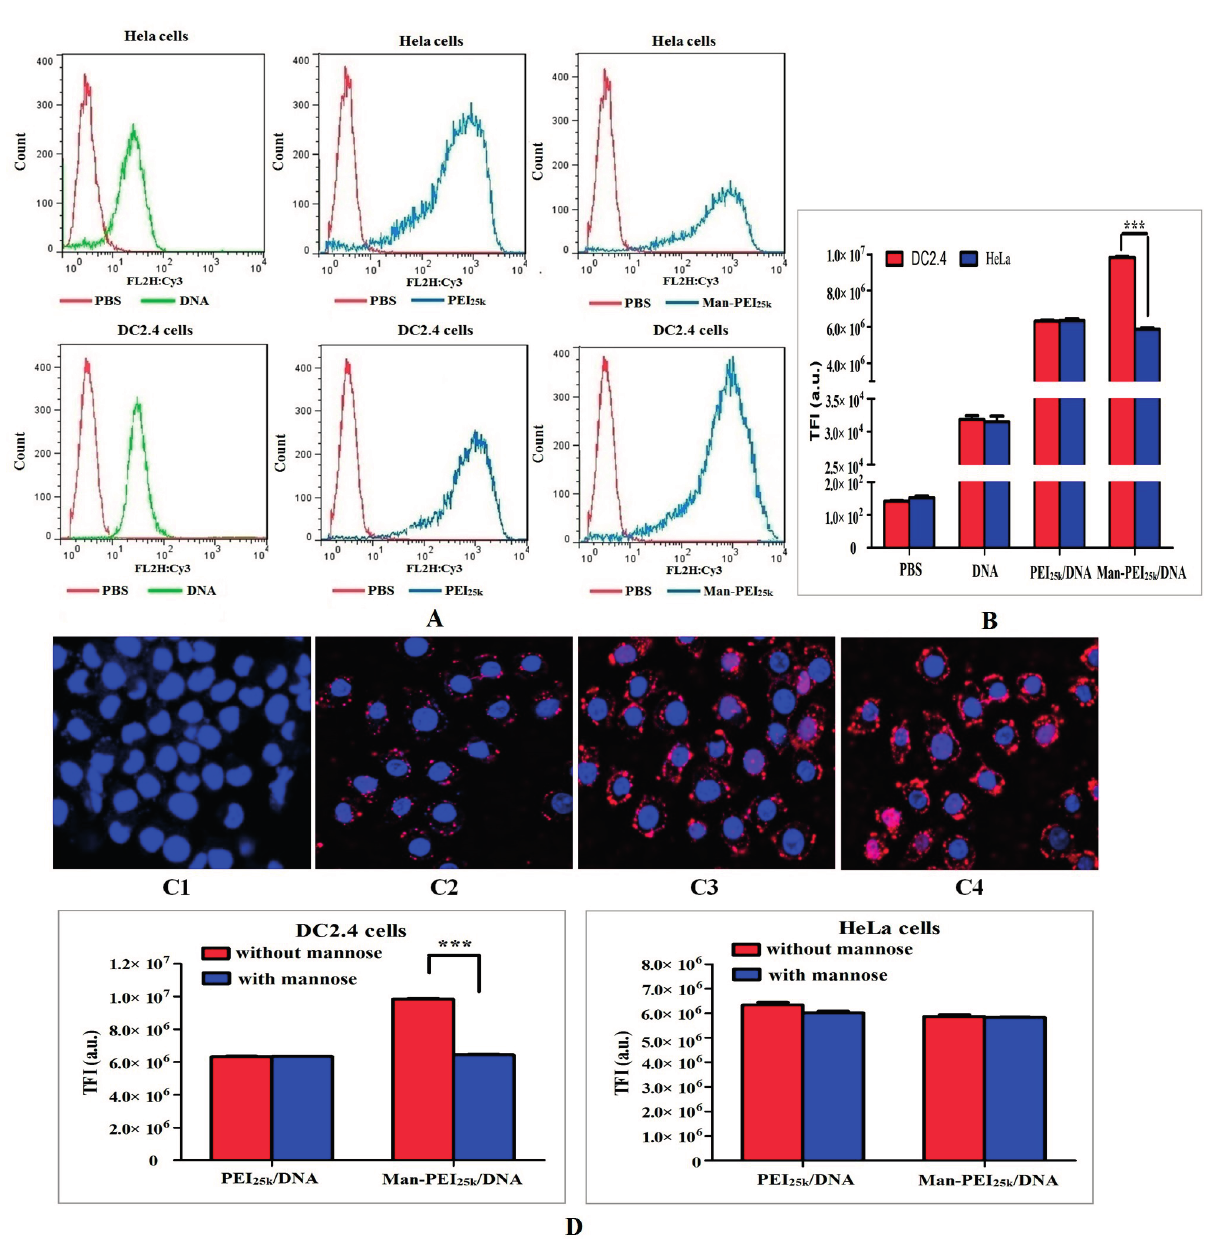
Figure 6. Cell uptake efficiency: ( A ) Representative series of flow cytometry histograms; ( B ) Total fluorescence intensity of each group in the two different cell lines; ( C ) Confocal micrographs showing the cellular uptake of the complexes in DC2.4 cells; The DNA was labeled with Cy 3 (red). The nuclei were stained with DAPI (blue). C1, DC2.4 cells without treatment; C2, naked DNA; C3, PEI 25k /DNA; C4, Man-PEI 25k /DNA; and ( D ) Competition assay with mannose in the two different cell lines. Each data point represents the mean ± standard deviation ( n = 6). *** p <